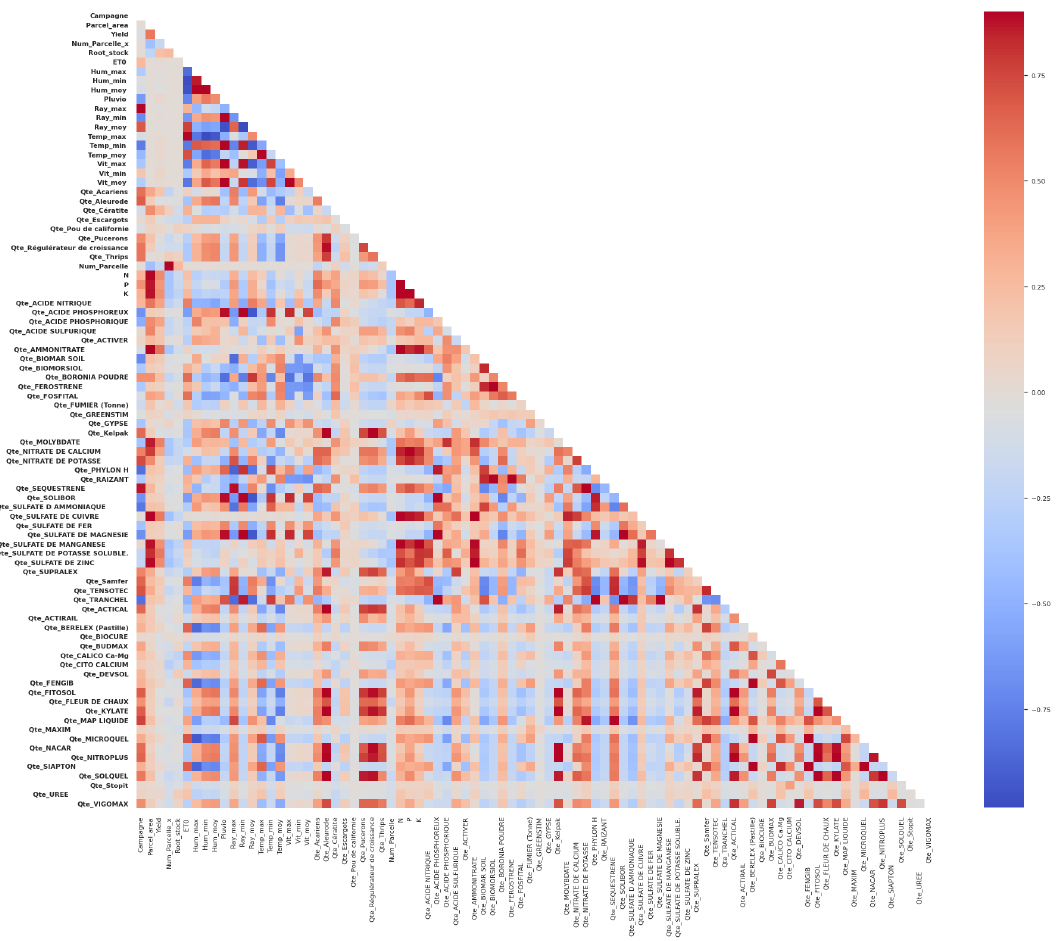
Figure 5. Correlation matrix between input variables.